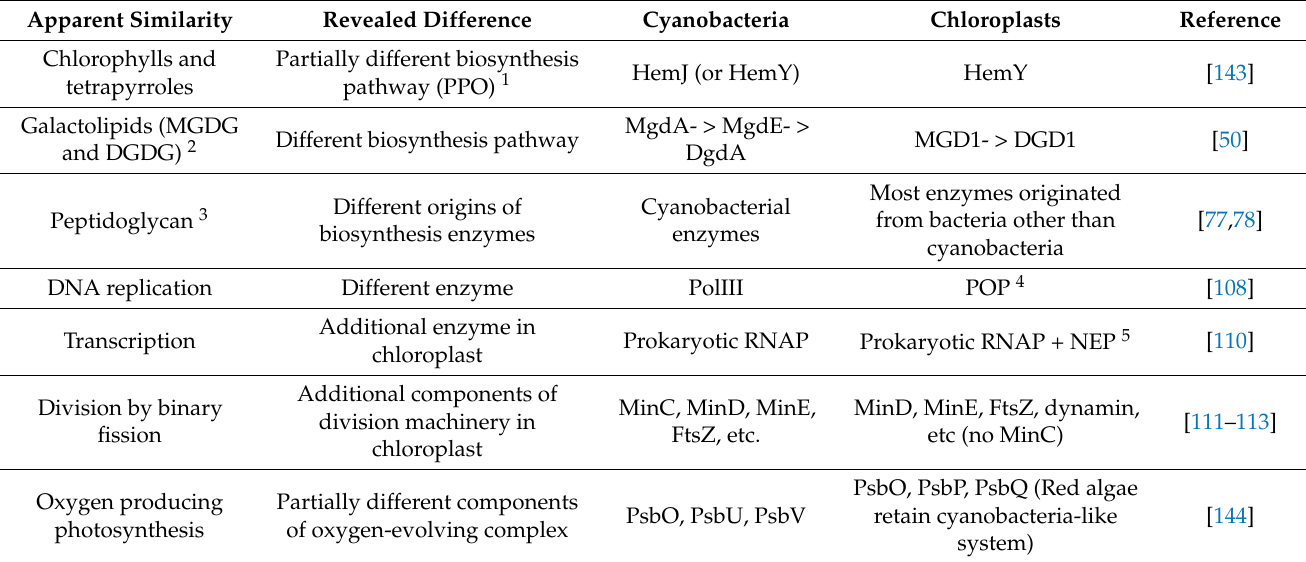
Table 2. The similarity of chloroplasts and cyanobacteria turned out to be explained by different mechanisms.